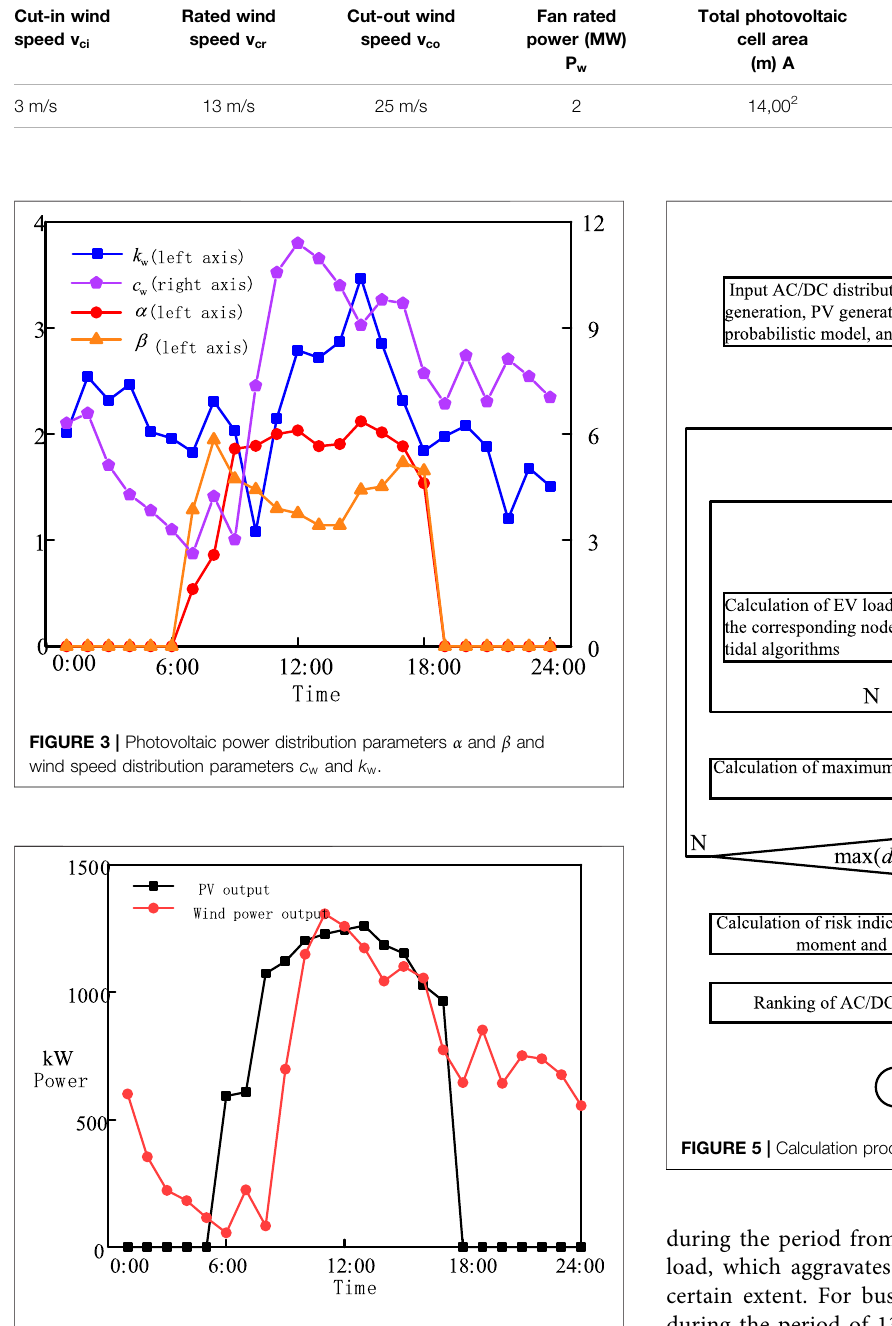
FIGURE 4 | Output of wind-PV in each period.